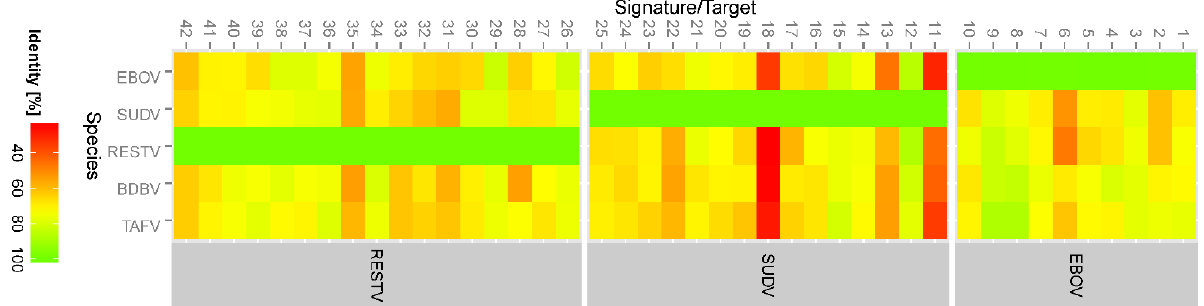
Figure 4. Various ebolavirus-specific Conserved Sequence Domains (CSD) vs. Signature Sequence Domains (SSD) identified using Bio Velocity . The bars are color coded according to the k-mer size.